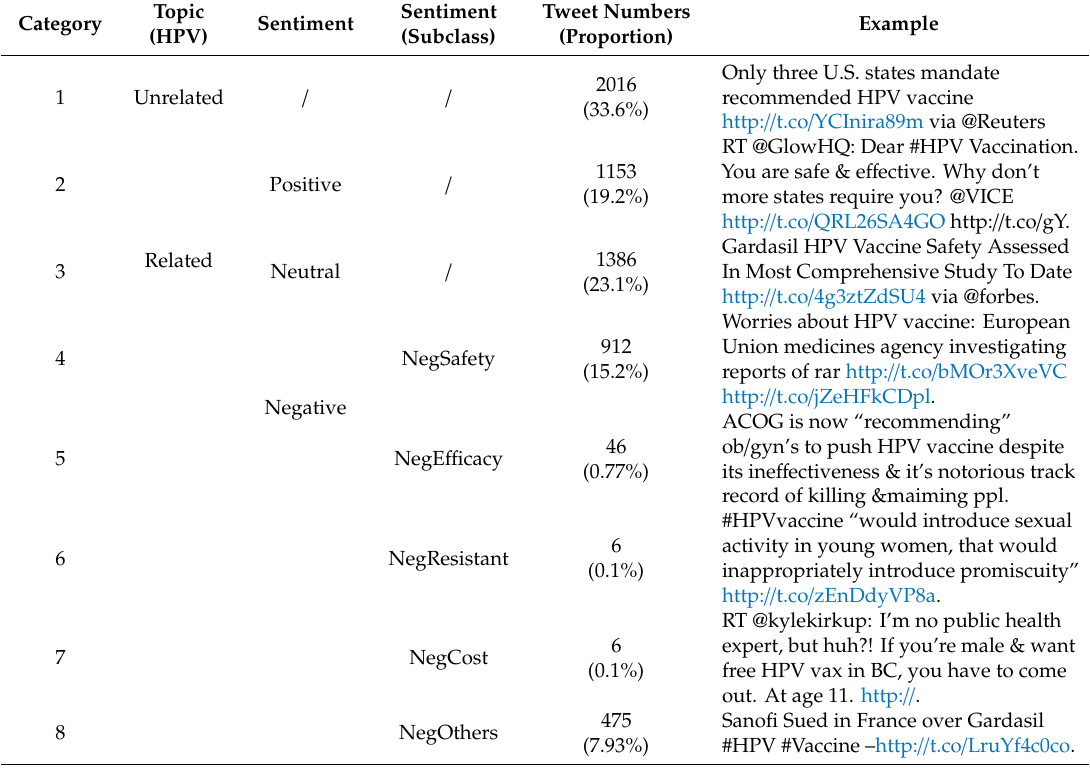
Table 1. The detailed proportion of each category.